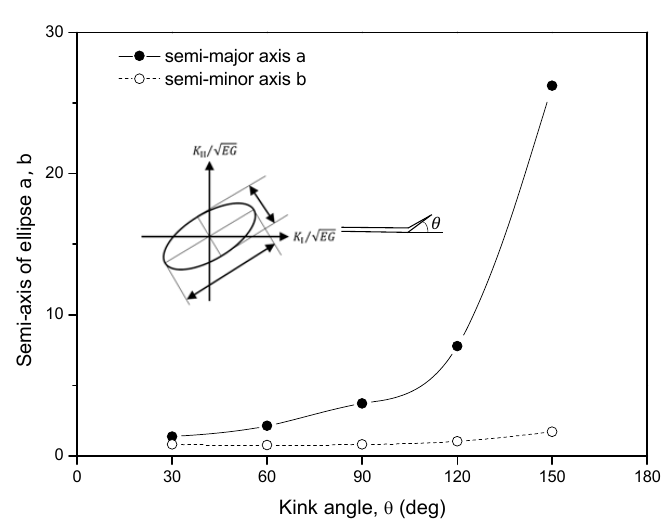
Figure 7. Semi ‐ major and semi ‐ minor axis of the Iso ‐ energy release rate.